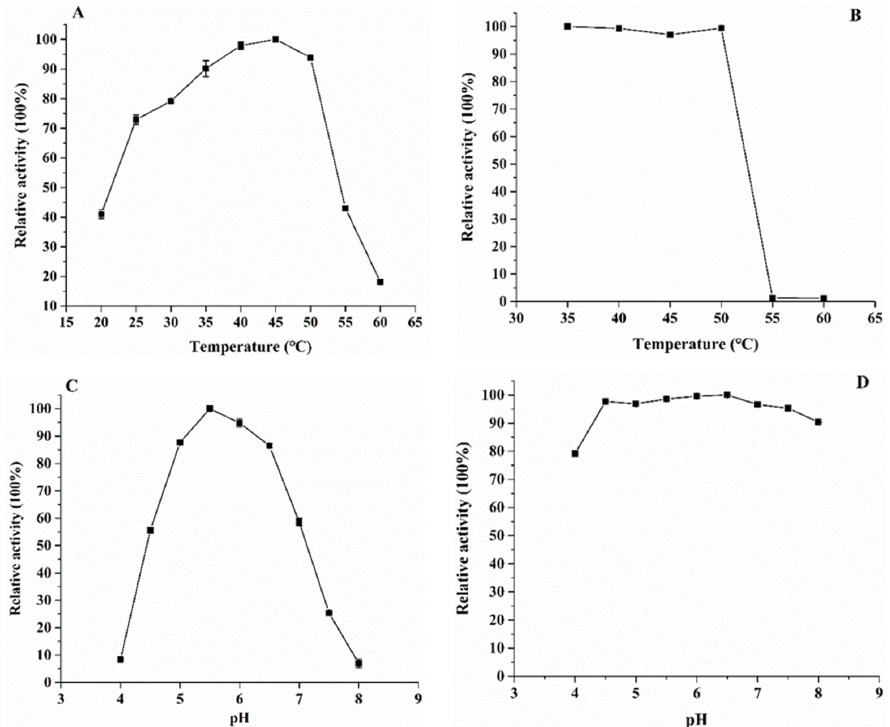
Figure 5. Effects of temperature and pH on the properties of KsLX3-SIase. Effect of temperature on enzyme activity ( A ) and stability ( B ). Effect of pH on enzyme activity ( C ) and stability ( D ). Data are the means ± SD from triplicate samples.